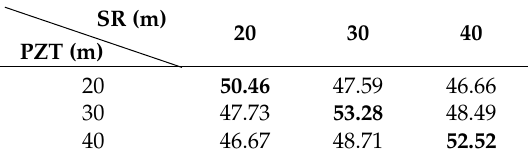
Table 1. The SNRs of three PZTs at different SRs (unit is dB).